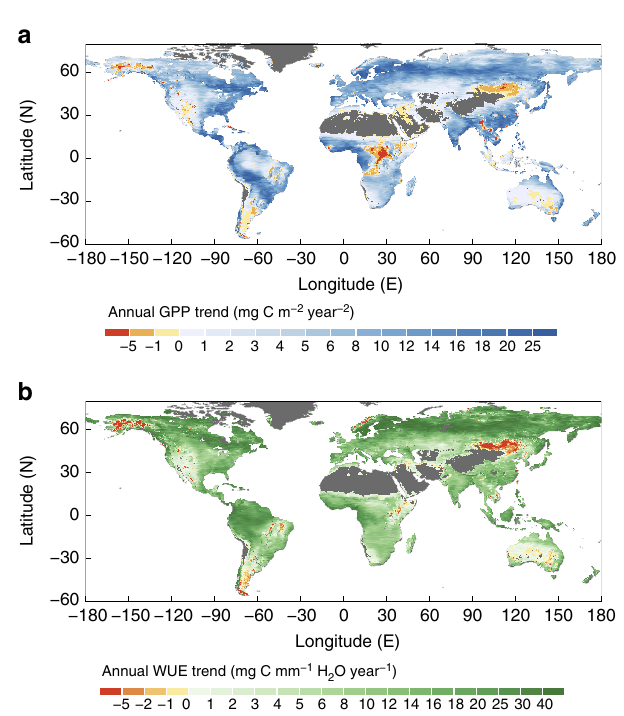
Fig. 3 Estimated spatial trends in annual gross primary production and water use ef fi ciency over 1982 – 2011. a Spatial variation (0.5° × 0.5°) of the linear trend in ecosystem GPP in g C m − 2 per year 2 . b Spatial variation (0.5° × 0.5°) of the linear trend in ecosystem WUE in mg C mm − 1 H 2